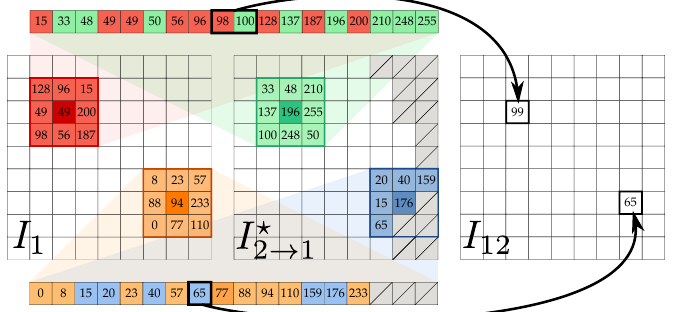
Figure 5. Application of the stacked median operator (cid:12) for computing I 12 from I 1 ∪ I (cid:63) ( x , y ) , the stacked median operator takes the union of the corresponding 3 × 3 local neighbourhoods for each image of the input set (in the example, the union of the red and green neighbourhoods, and the union of the orange and blue ones, missing data are represented in the figure as gray ticked boxes) and assigns its median intensity value to the point ( x , y ) in the new image. Best viewed in